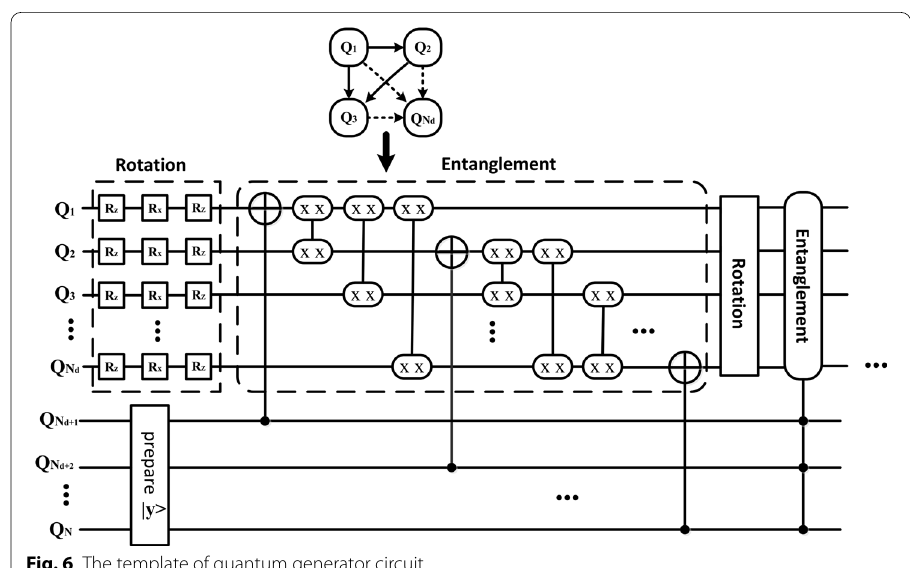
Fig. 6 The template of quantum generator